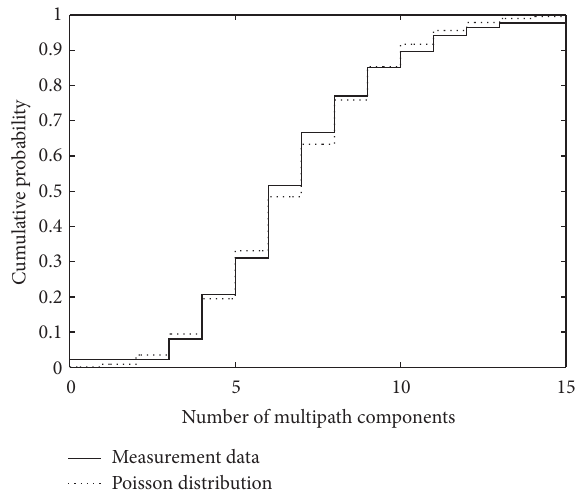
Figure 8: CDF of the number of multipath components for building